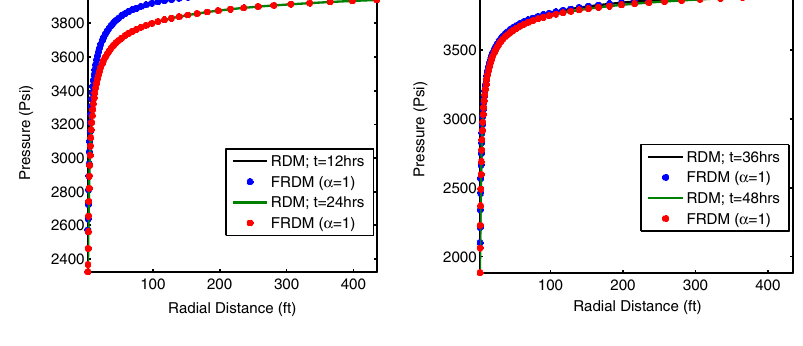
Fig. 4 Fractional radial diffusivity model shows decreased p wf for variation in a at 12